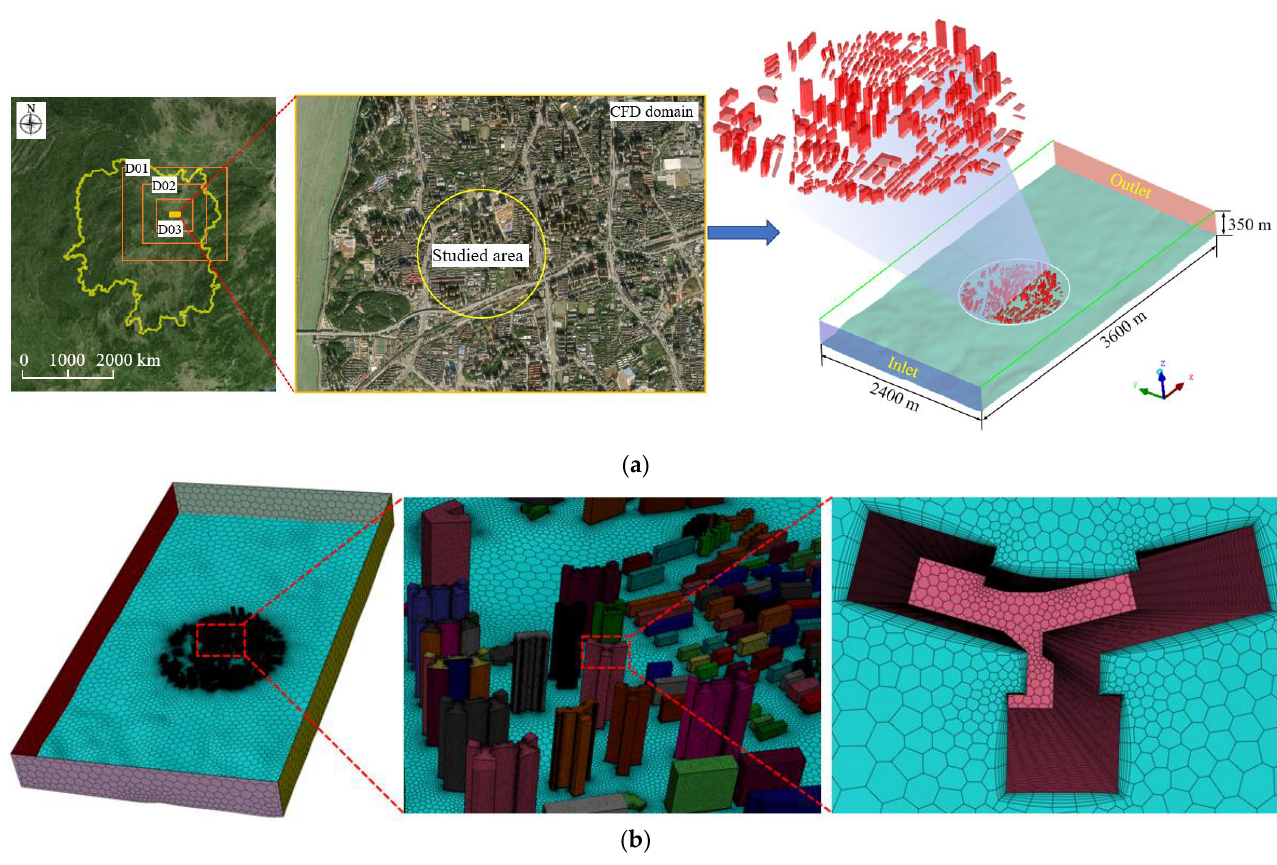
Figure 8. Numerical model of study area: ( a ) computation domain; ( b ) mesh configuration.